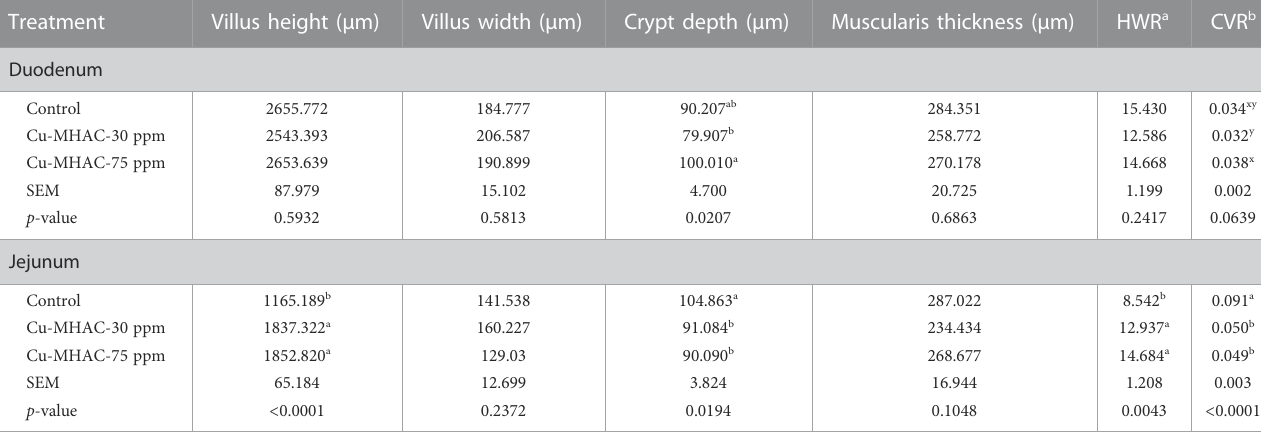
TABLE 7 Duodenal and jejunal morphometry of broilers at 41 days of age. Treatment